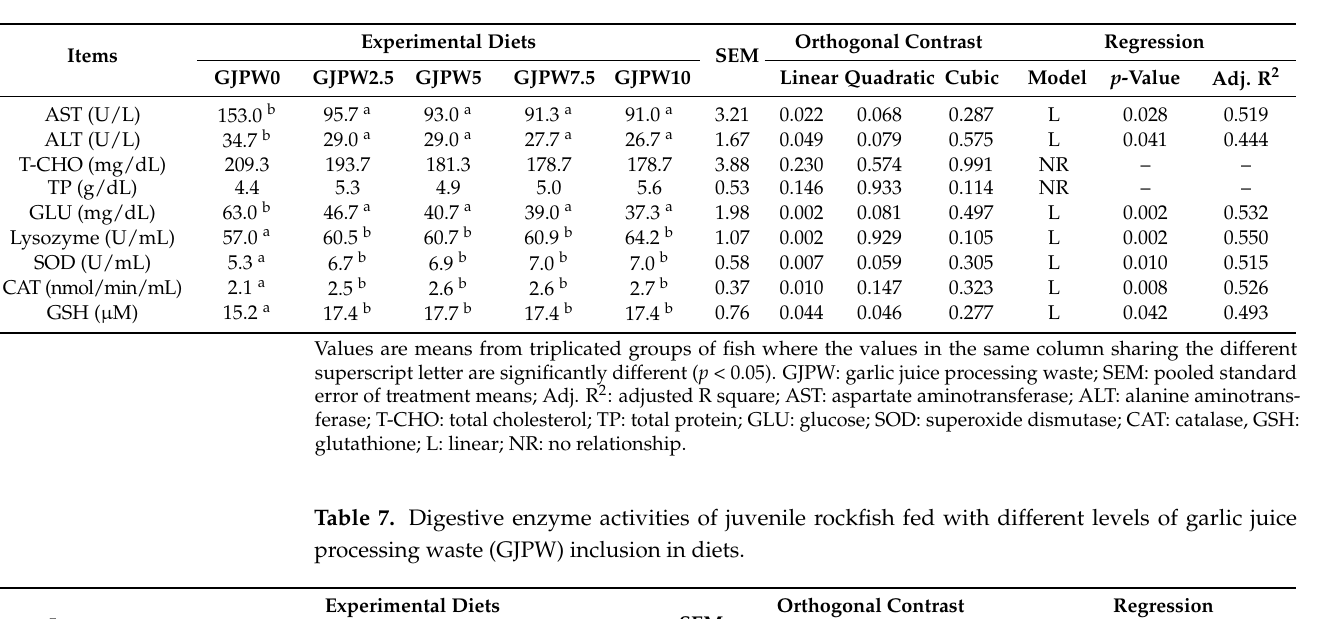
Table 6. Hematologic parameters of juvenile rockfish fed with different levels of inclusion of garlic juice processing waste (GJPW) in diets.